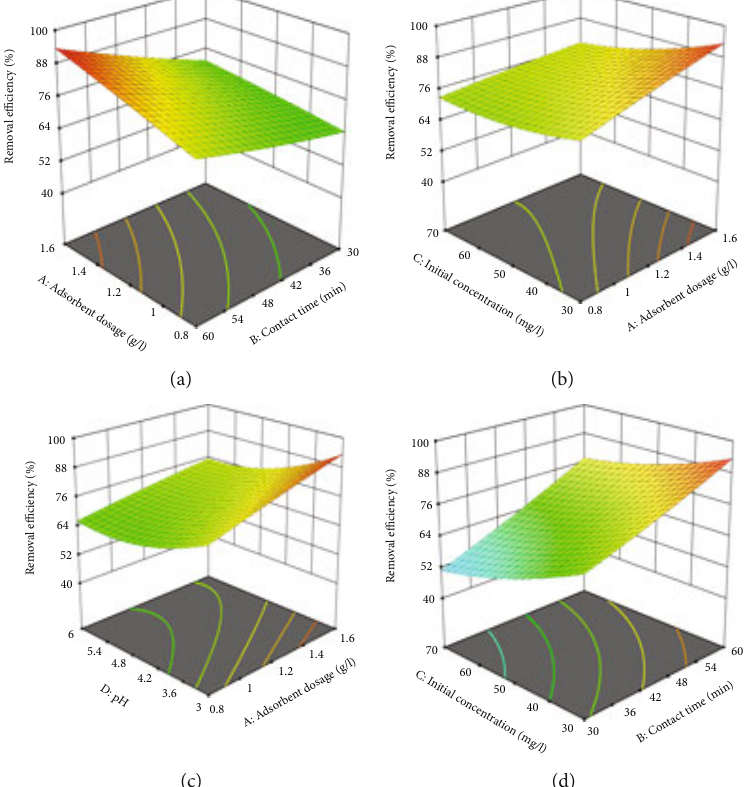
Figure 7: 3D response curve for interaction between adsorbent dose and contact time (AB), adsorbent dose and initial concentration (AC), adsorbent dose and pH (AD), and contact time and initial concentration